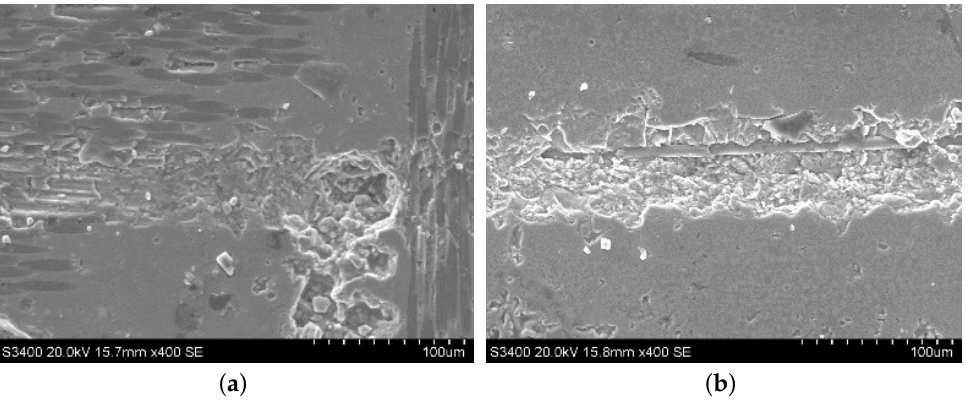
Figure 4. Typical surface morphologies of the SiC region in C/SiC composite after ordinary cutting and ultrasound-assisted grinding. ( a ) is ordinary grinding and ( b ) is ultrasound-assisted